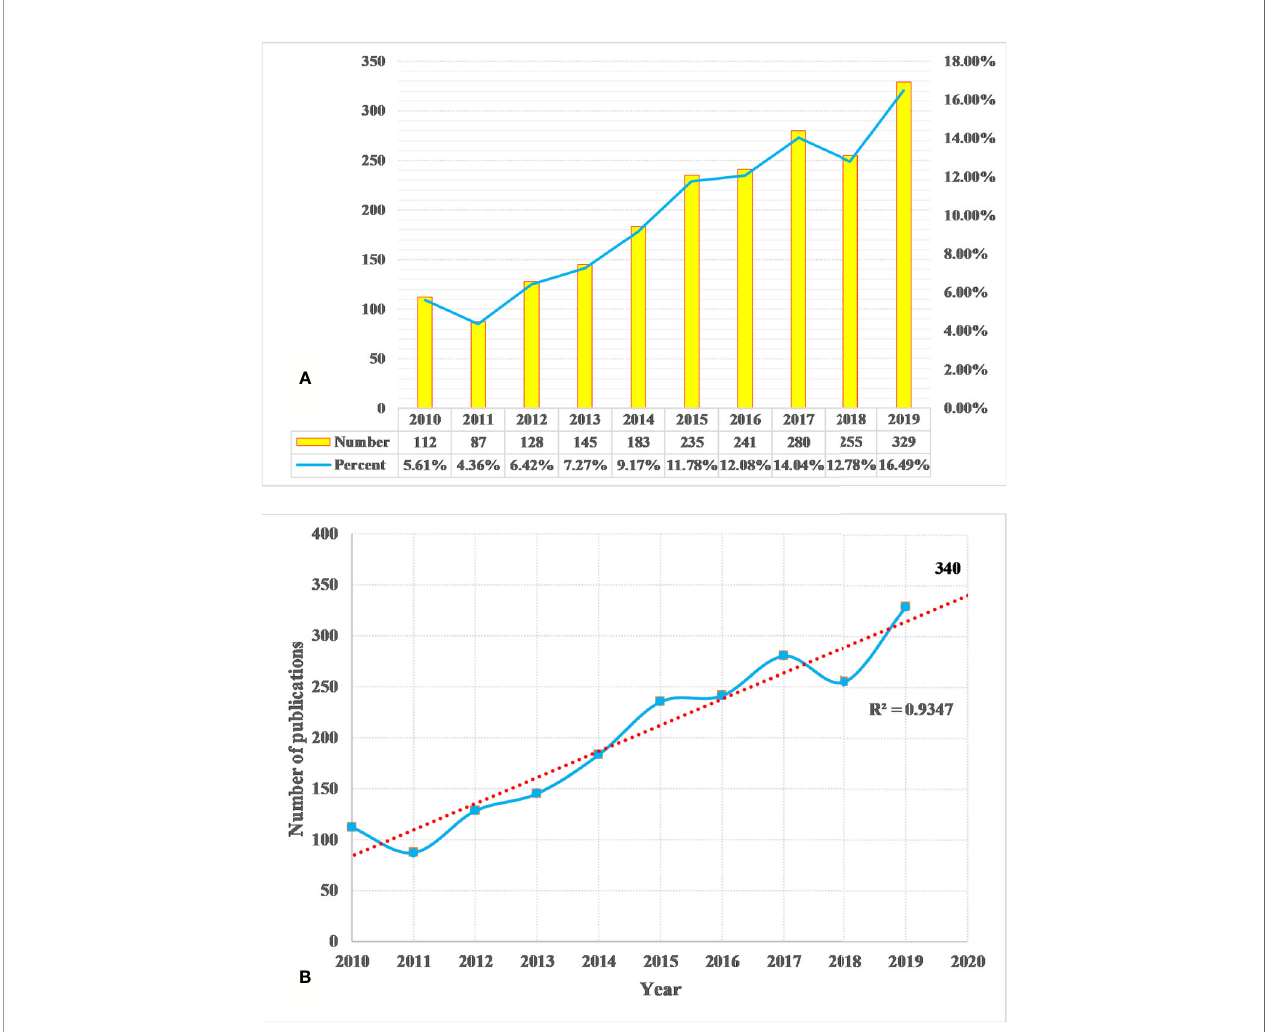
FIGURE 1 | Annual output of drug-induced liver injury (DILI) research (A) and the linear fi tting of publication growth in DILI research (B) .